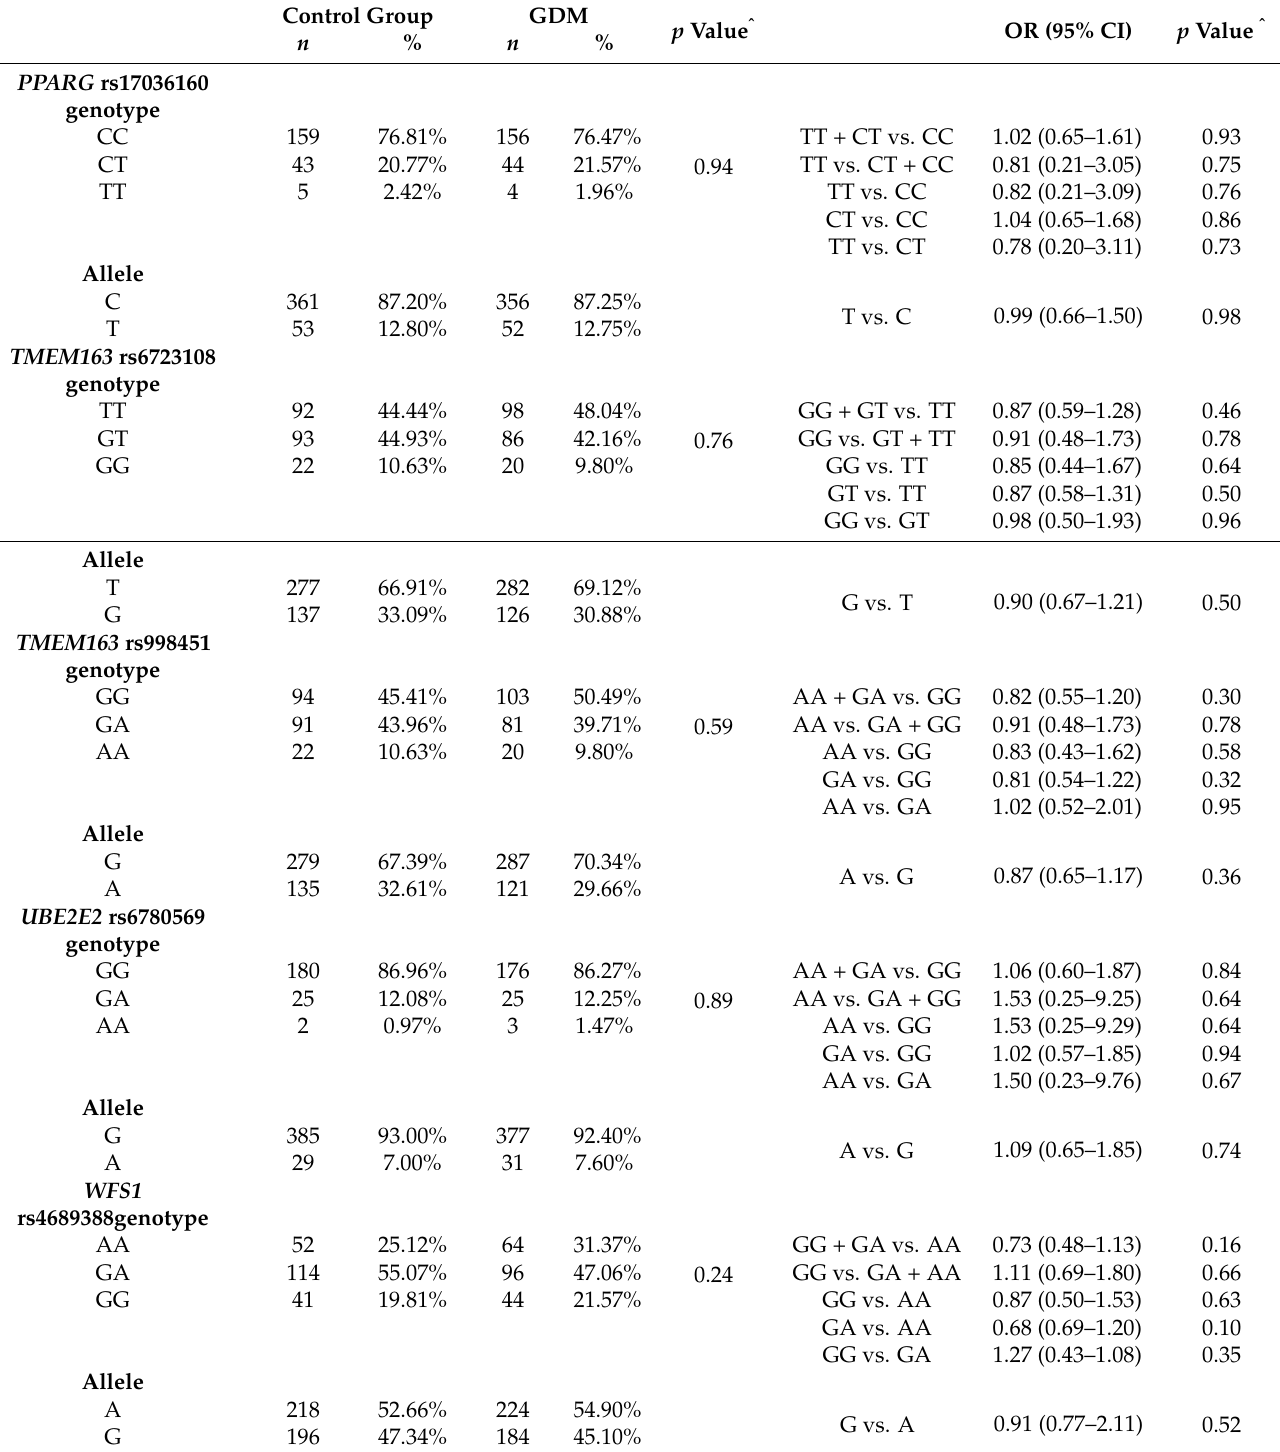
Table 1. Distribution of PPARG, TMEM163, UBE2E2, and WFS1 genotypes and alleles in women with GDM and control